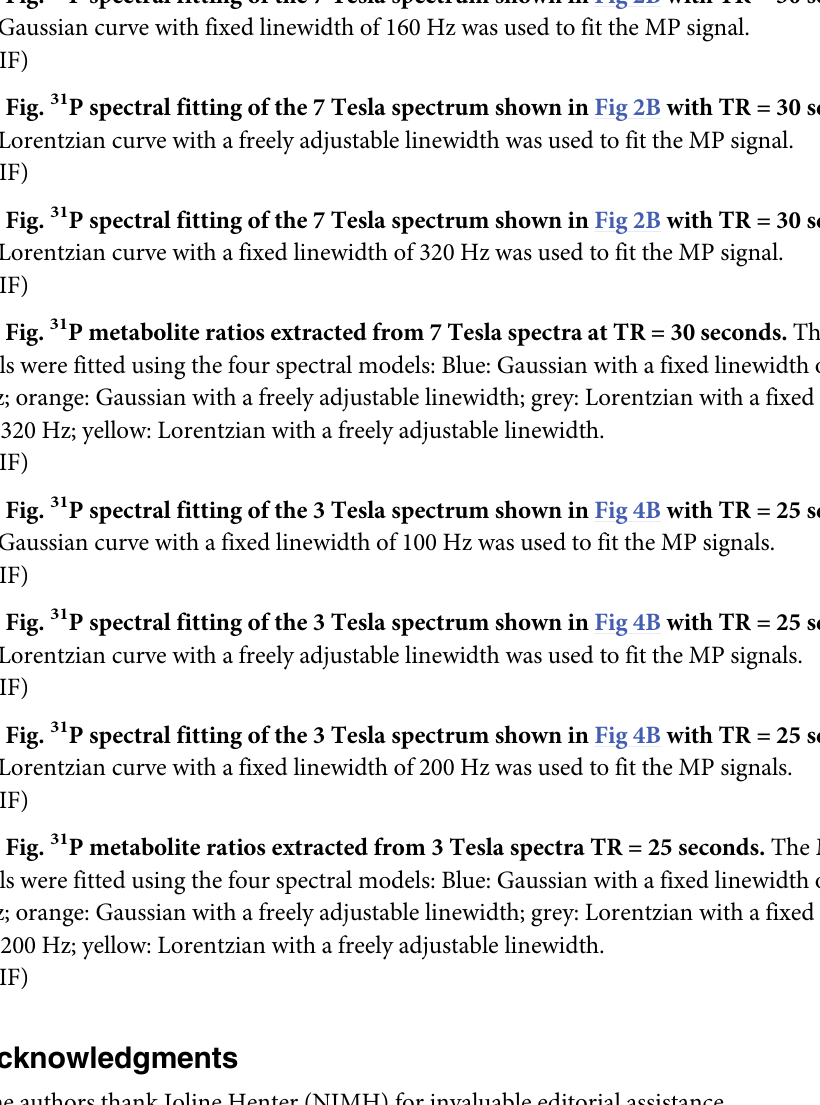
S3 Fig. 31 P spectral fitting of the 7 Tesla spectrum shown in Fig 2B with TR = 30 seconds. A Lorentzian curve with a fixed linewidth of 320 Hz was used to fit the MP signal. S4 Fig. 31 P metabolite ratios extracted from 7 Tesla spectra at TR = 30 seconds. The MP sig- nals were fitted using the four spectral models: Blue: Gaussian with a fixed linewidth of 160 Hz; orange: Gaussian with a freely adjustable linewidth; grey: Lorentzian with a fixed linewidth of 320 Hz; yellow: Lorentzian with a freely adjustable linewidth. S5 Fig. 31 P spectral fitting of the 3 Tesla spectrum shown in Fig 4B with TR = 25 seconds. A Gaussian curve with a fixed linewidth of 100 Hz was used to fit the MP signals. S6 Fig. 31 P spectral fitting of the 3 Tesla spectrum shown in Fig 4B with TR = 25 seconds. A Lorentzian curve with a freely adjustable linewidth was used to fit the MP signals. S7 Fig. 31 P spectral fitting of the 3 Tesla spectrum shown in Fig 4B with TR = 25 seconds. A Lorentzian curve with a fixed linewidth of 200 Hz was used to fit the MP signals. S8 Fig. 31 P metabolite ratios extracted from 3 Tesla spectra TR = 25 seconds. The MP sig- nals were fitted using the four spectral models: Blue: Gaussian with a fixed linewidth of 100 Hz; orange: Gaussian with a freely adjustable linewidth; grey: Lorentzian with a fixed linewidth of 200 Hz; yellow: Lorentzian with a freely adjustable